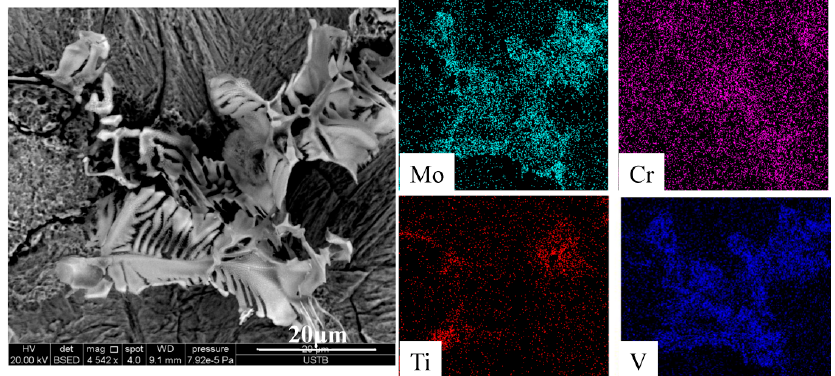
Figure 10. Elemental mapping of the primary carbide in the three-dimensional observation.